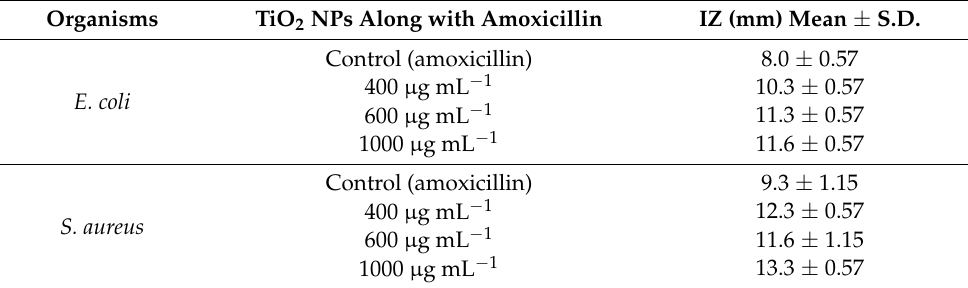
Table 2. Inhibition zone in mm (mean ± standard deviation) of TiO 2 NPs with amoxicillin.